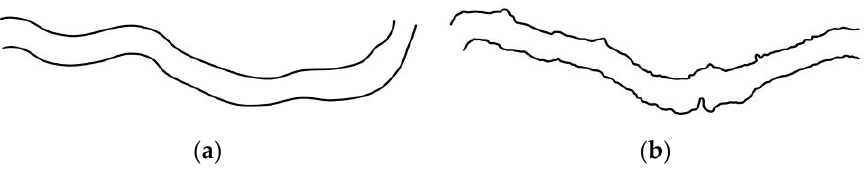
Figure 7. Curves to be compared: ( a ) curve A ’s; and ( b ) curve B ’s features’ description sequence. Firstly, dividing the double line into an upper curve 𝐶 ↾ and a lower curve 𝐶 ⇂ , the curvature constraint thresholds of the curves are 𝜁 ↾ and 𝜁 ⇂ , respectively. Then, curves 𝐶 ↾ and 𝐶 ⇂ are initially segmented, the segment curvature is calculated, and the feature description set of the upper curve and the lower curve is obtained. By integrating them under the same coordinate system (Figure 8a,b), the geometric similarity between curve A and curve B is calculated using Equation (7).